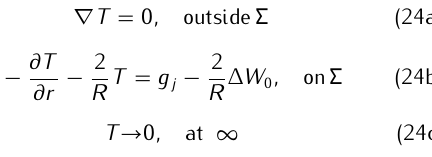
Figure 6. Vertical datum parameters by non-connected height sys-